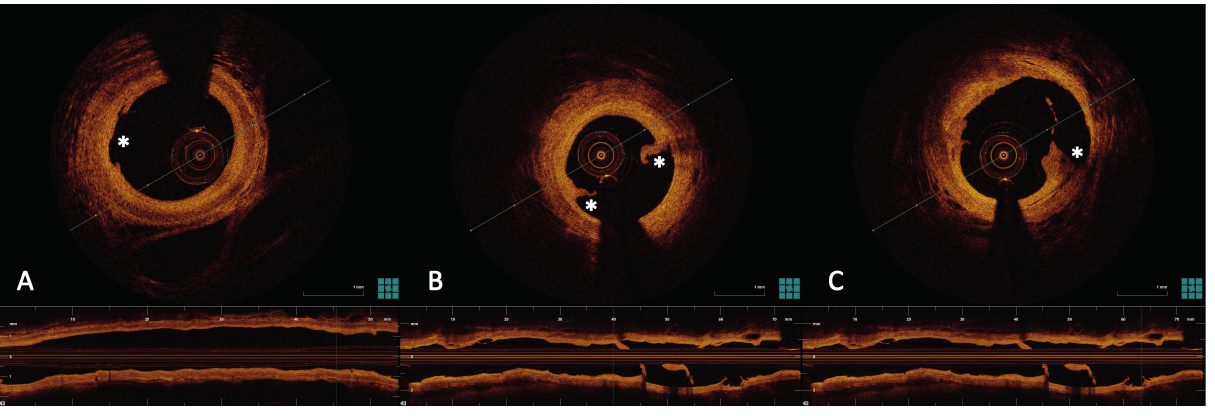
Fig. 3. representative ocT pictures of radial artery injuries. a-intimal tear, B-medial dissection, c-perforation. pathology marked by asterisk(s) in every